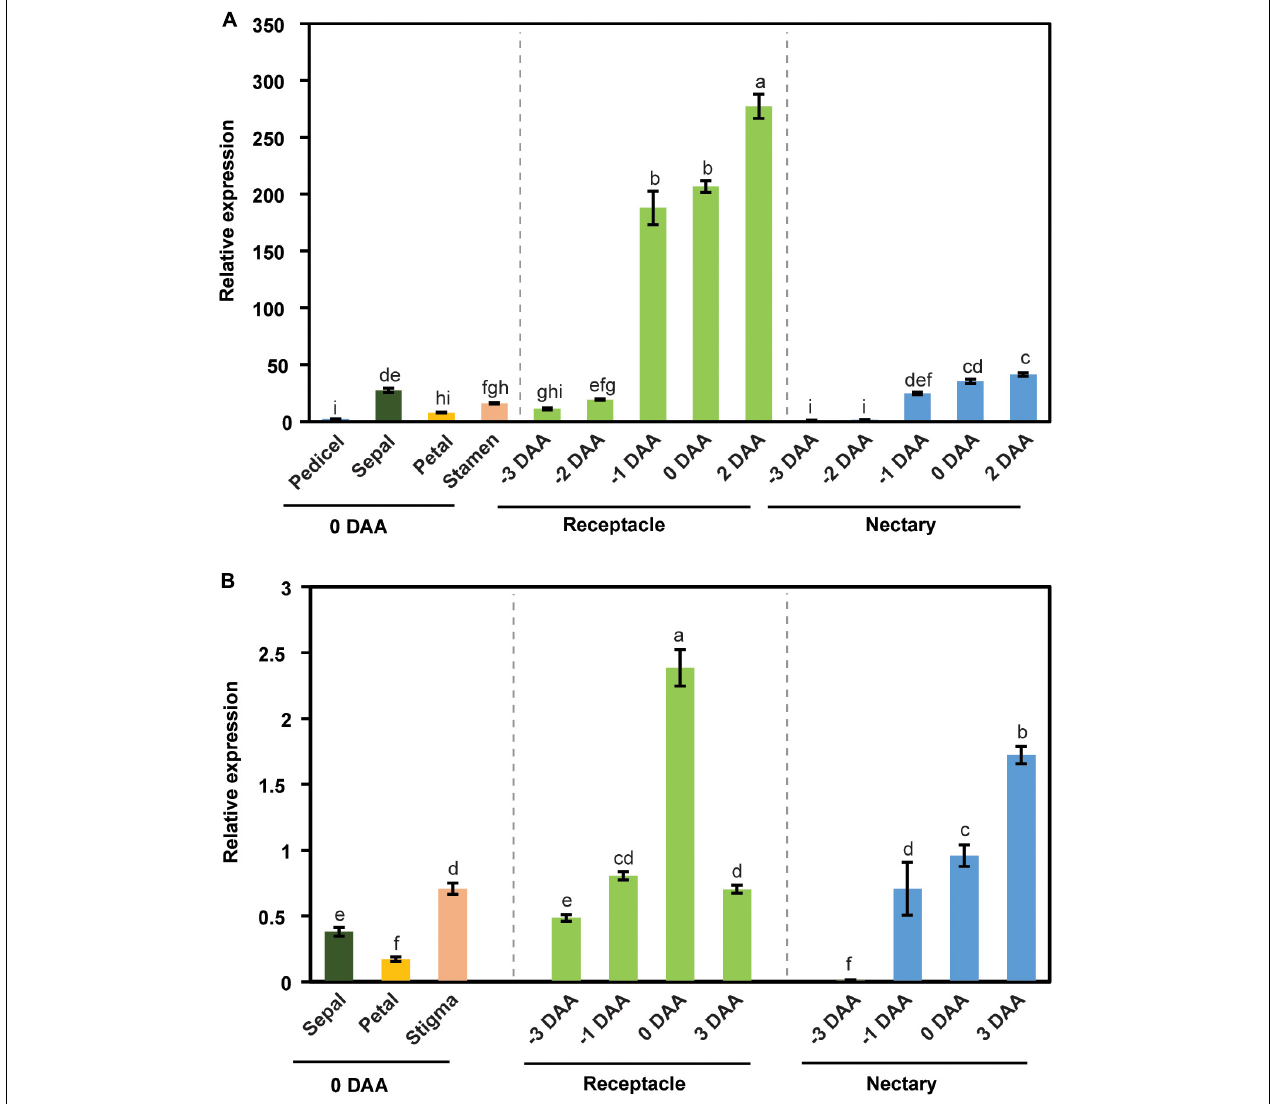
FIGURE 2 | The expression pattern of CsSWEET7a in male (A) and female flowers (B) . DAA, days after anthesis; − 3, − 2, − 1 DAA, being 3, 2, and 1 day(s) before anthesis, respectively; 0 DAA, the day of anthesis; and 2 and 3 DAA, being 2 and 3 days after anthesis, respectively. Mean values ± SE of three independent biological replicates were shown. Statistical analyses were performed using one-way ANOVA followed by multiple comparisons using Fisher’s LSD method ( P -value <